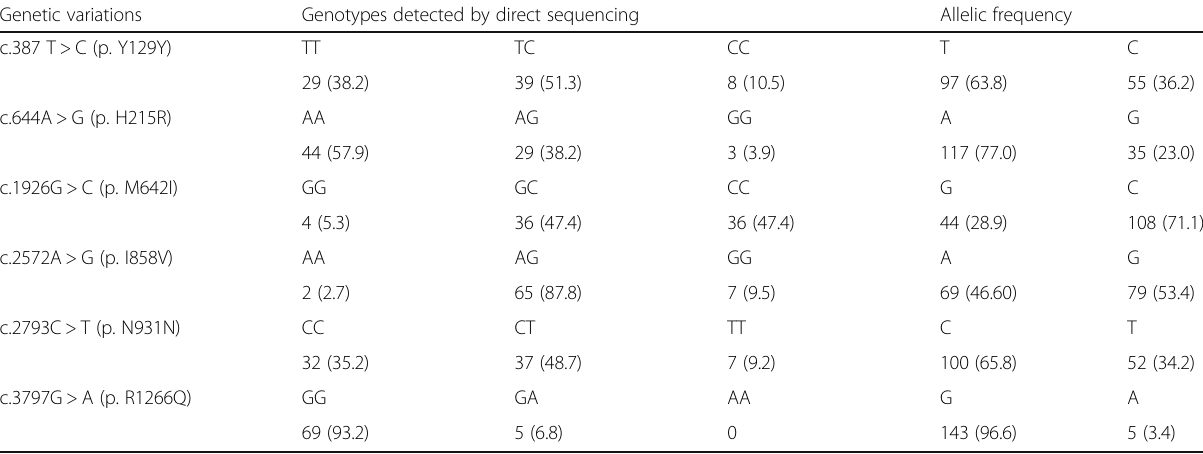
Table 1 Distribution of NPC1 polymorphism genotype and allelic frequency among members of the extended pedigree ( N =76) Genetic variations Genotypes detected by direct sequencing Allelic